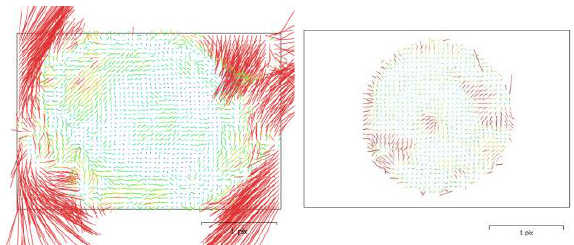
Figure 11. Comparison of the image residuals on the SA2 camera after the calibration. On the left, image residuals using the full image; on the right, image residuals cropping out the parts close to the edges of the